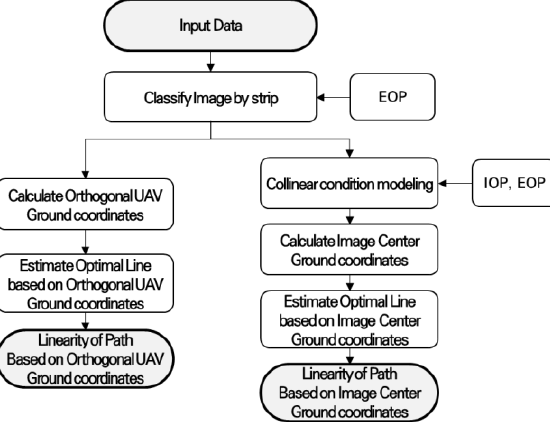
Figure 4. Linearity of path analysis